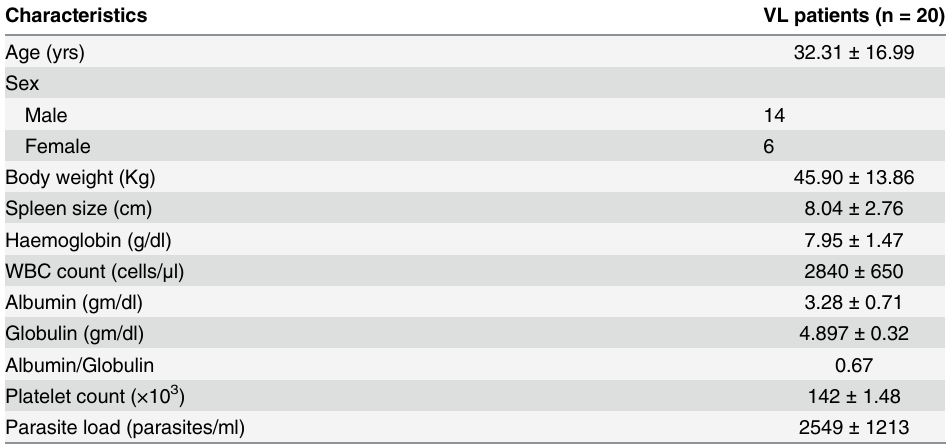
Table 1. Description of the study population by age, clinical and haematological parameters (Mean ± SD).